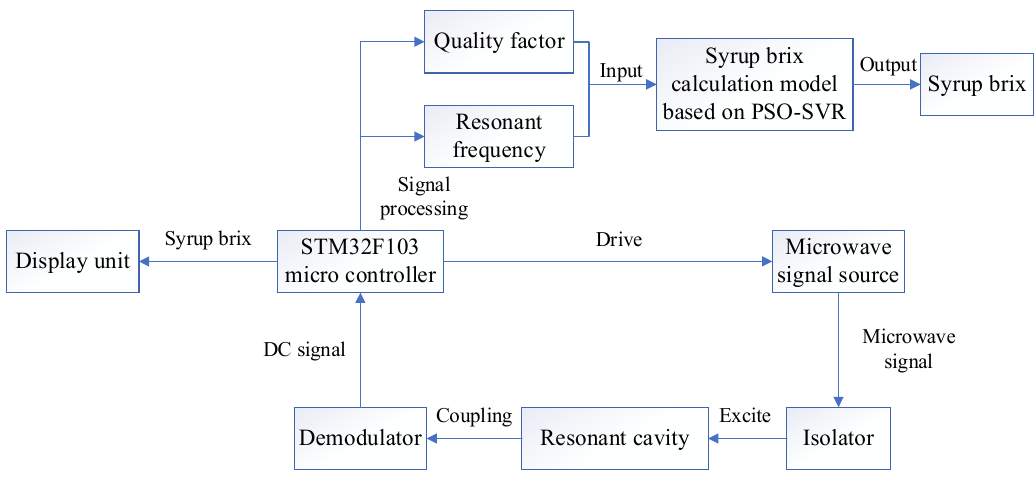
Figure 14. Working principle of syrup brix online measuring system.